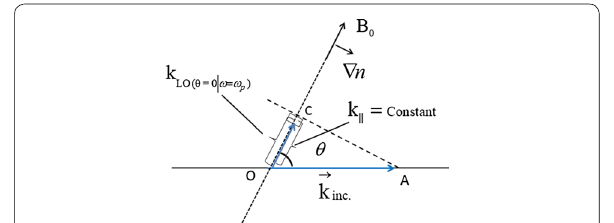
Fig. 3 Configuration of the background magnetic field, k -vector, and density gradient